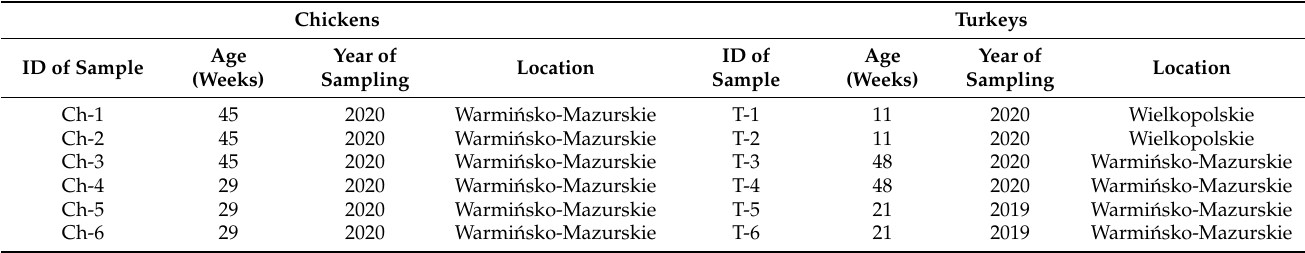
Table 1. Information on samples collected from chickens and turkeys yielding DNA of sufficient quality for further